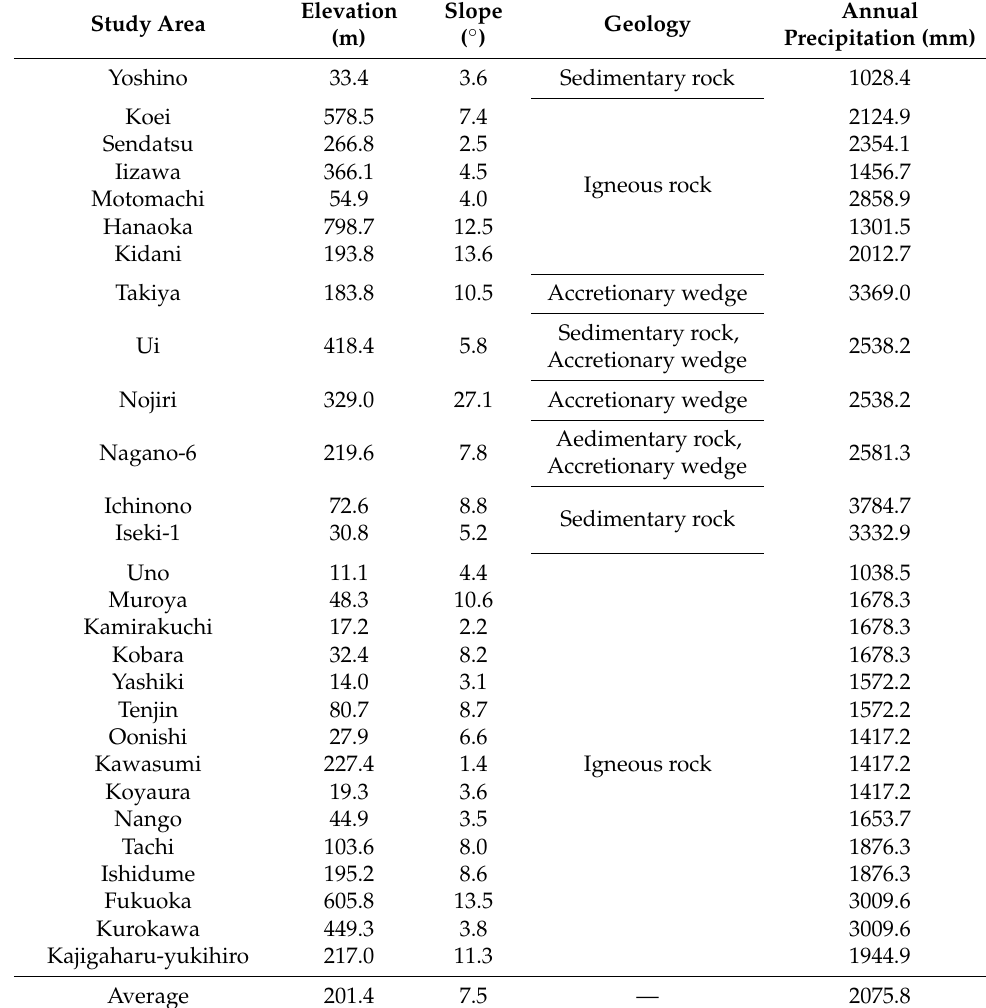
Table 2. Topography, geology, and rainfall conditions of the study